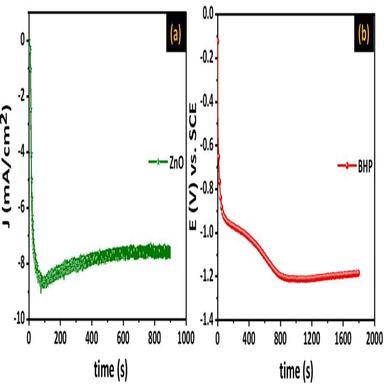
(a) Chronoamperometric diagram of ZnO deposited on FTO, (b) Chronopotentiometry diagram of BHP Deposit on ZnO Electrode.